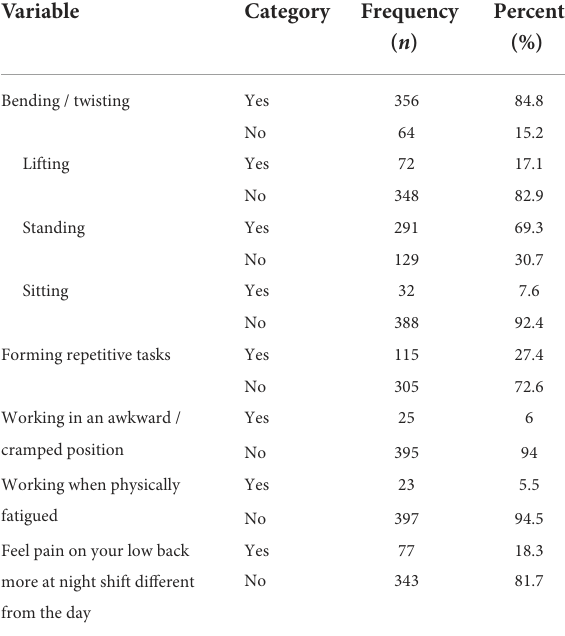
TABLE 2 Personal and psychological characteristics of restaurant wait staff in Gondar town, Ethiopia, 2019 ( n = 420).